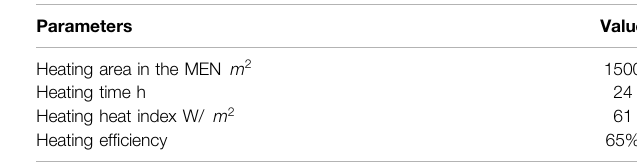
TABLE 5 | The rated heating parameters of the ZCE-MEN.